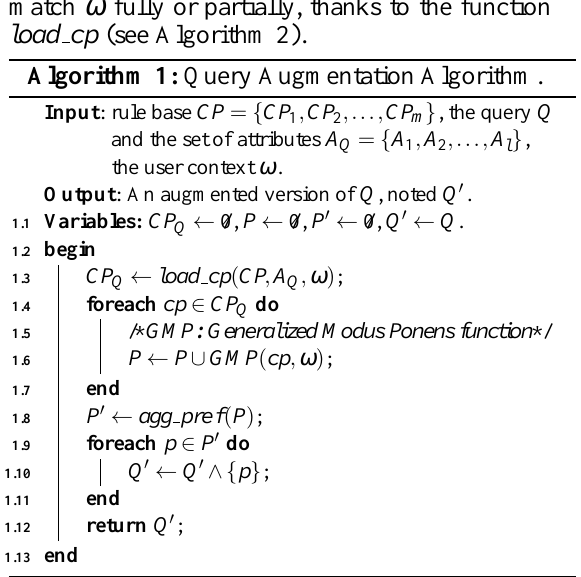
Algorithm 1: Query Augmentation Algorithm.